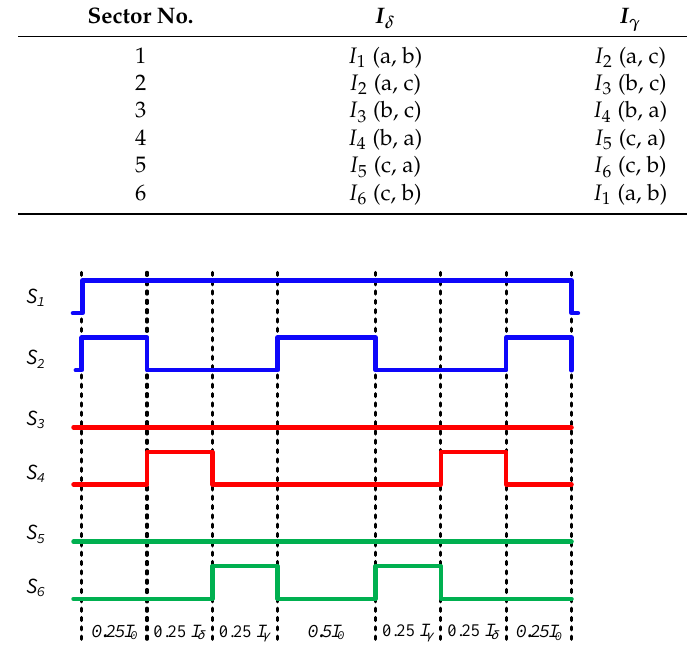
Figure 3. Switching sequence for the rectifier in the first sector. Table 1. Switching sequence for the rectifier for different sectors to minimize switching losses. Sector No.